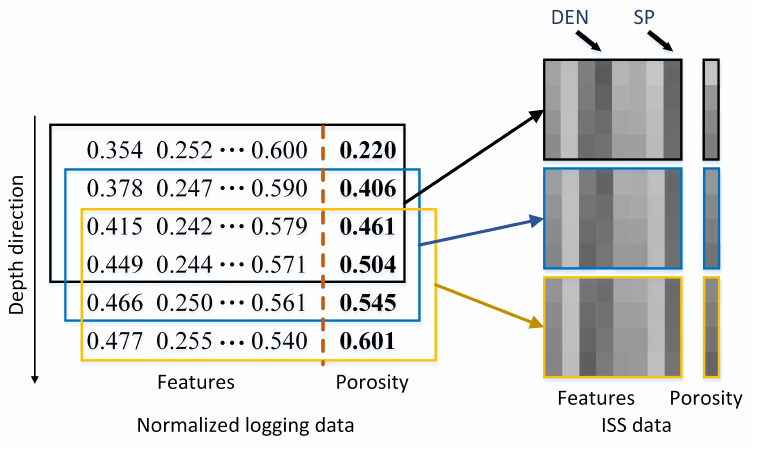
Figure 7. ISS construction process.